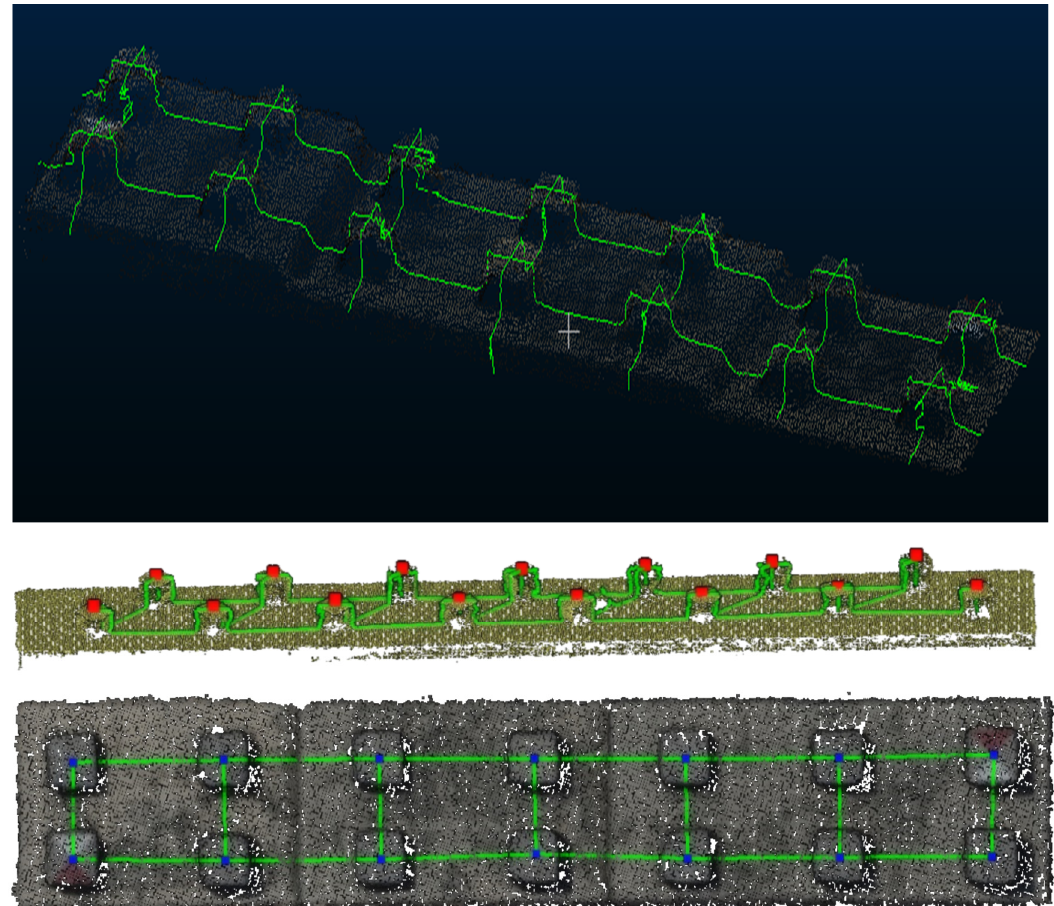
Figure 5. RANSAC for sphere fitting of the pier pad points.